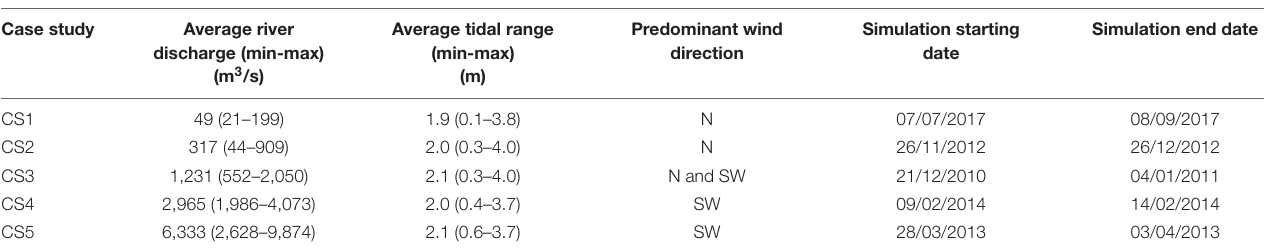
TABLE 1 | Summary of the conditions simulated for each case